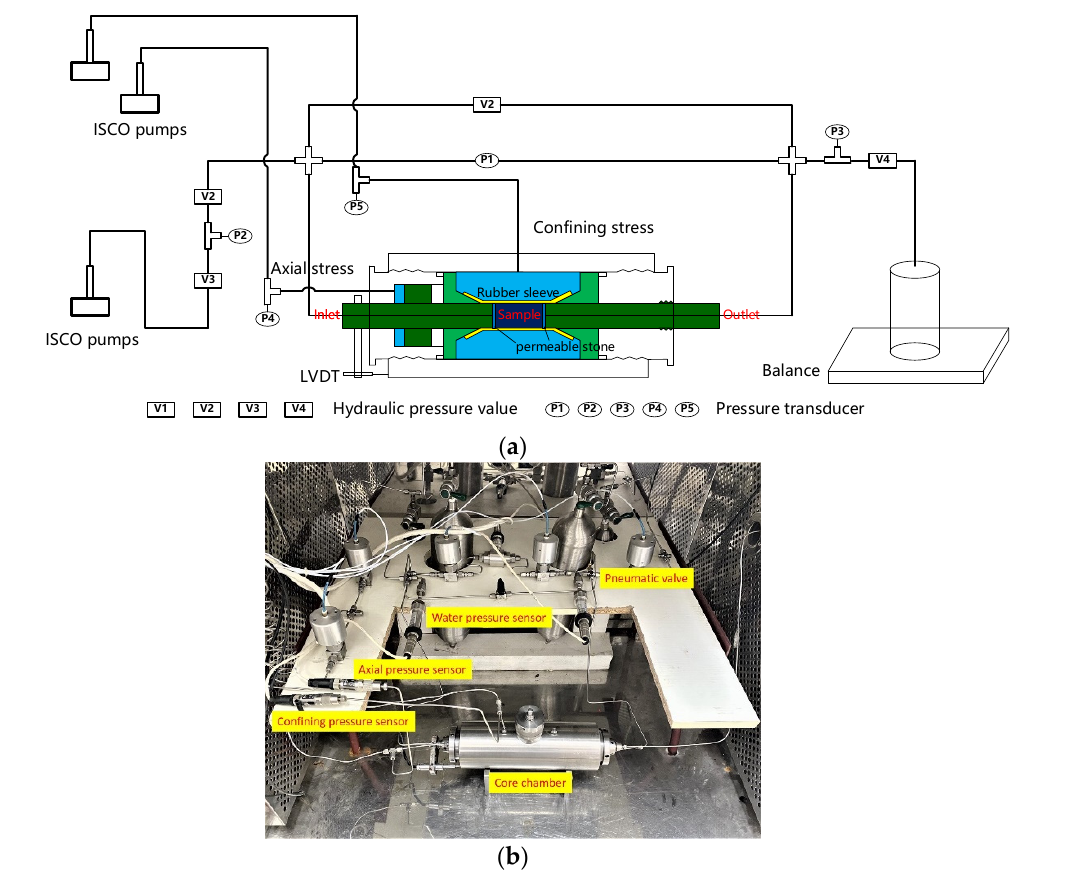
Figure 5. ( a ) Diagram of the permeability measurement apparatus. ( b ) Real picture of the apparatus.